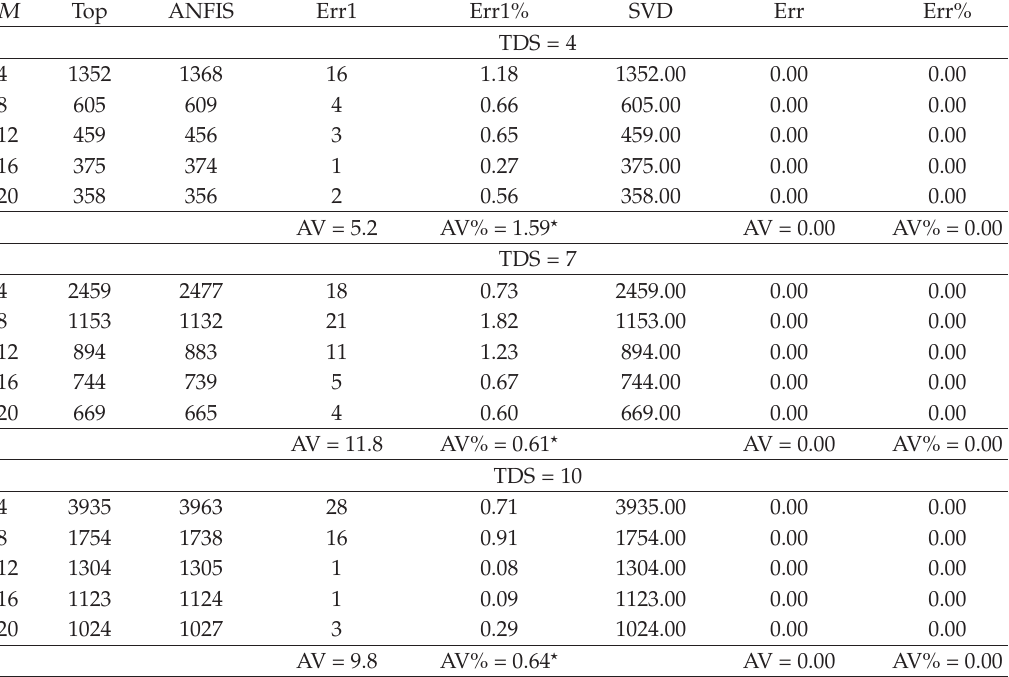
Table 8: Comparison of results by ANFIS and SVD for the CRP9 relay.